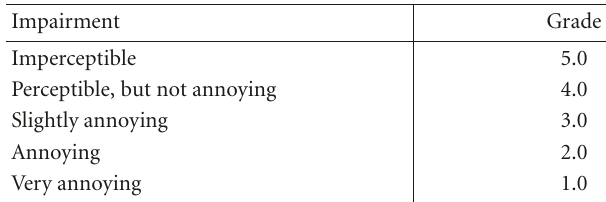
Table 2: Five-grade impairment scale.